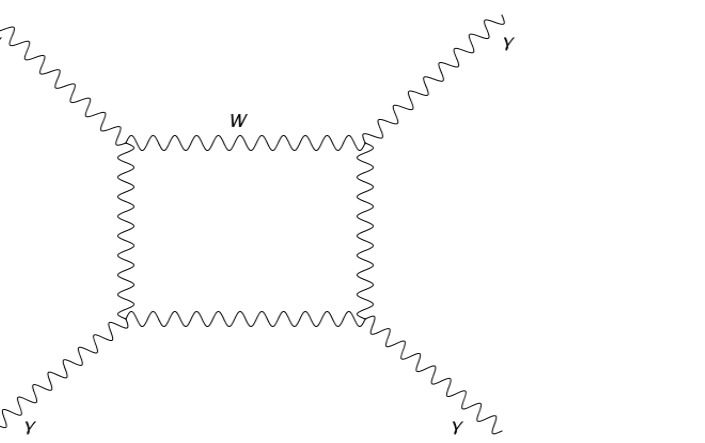
Figure 1. The box diagram related to the one-loop corrections to the process γγ γγ via W -boson loops. → Since the W boson is heavy, it is unstable and hence in principle we may not be allowed to cut the W internal lines. However, the W mass M is about 80 GeV and its decay width Γ is about 2 GeV [88], hence Γ M and in principle one is justified in resorting to (cid:28)